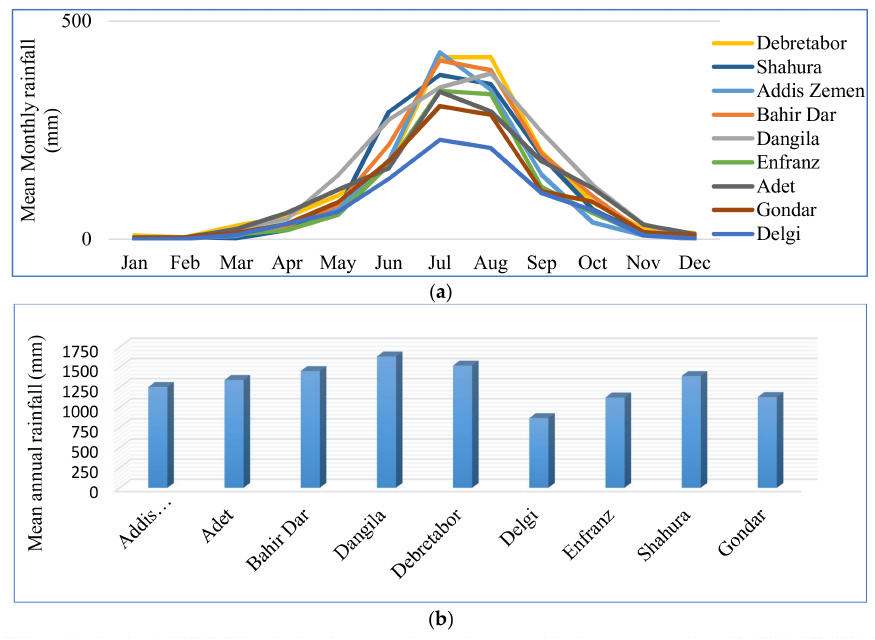
Figure 8. Rainfall depth (mm) ( a ) mean monthly; ( b ) mean